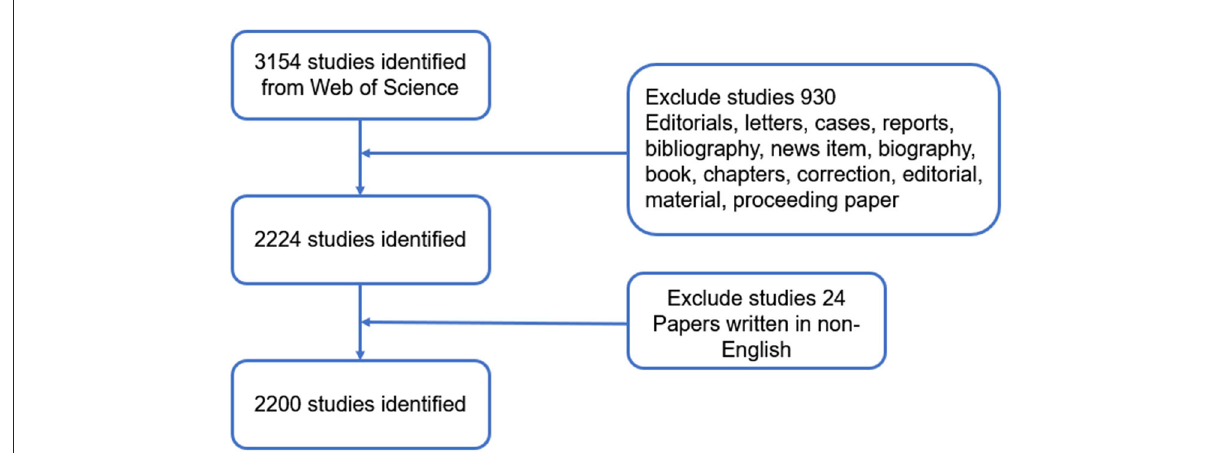
FIGURE1 Detailed flowchart of search, screening, and registration on the Web of Science.